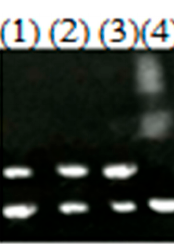
Figure 6. Electrophoretic mobility shift assays. Electrophoretic mobility shift assays showing the ability of FurA to bind in vitro to the promoter regions of mcyD . (1) The DNA fragments free. (2) The DNA fragments mixed with recombinant FurA protein at a concentration of 0.3 µM. (3) The DNA fragments mixed with Mn 2+ . (4) The DNA fragments and Mn 2+ mixed with the recombinant FurA protein at a concentration of 0.3 µM.